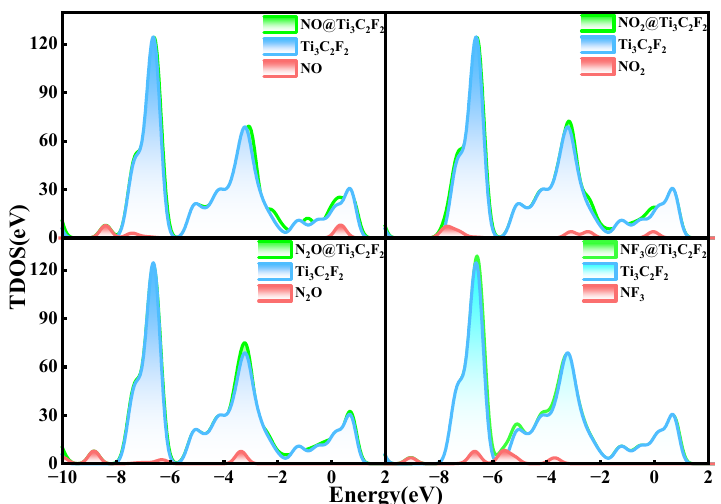
Figure 3. Total electron density of states of Ti 3 C 2 F 2 adsorbing NO, NO 2 , N 2 O, and NF 3 . In the PDOS of Figure 4, only a small part of the orbital overlaps between the atoms of NO, NO 2 , and N 2 O and the atoms of the material surface, indicating that the interactions between the atoms are not strong. The F 2p orbital of NF 3 has a partial overlap with the F 2p orbital of the surface around − 7 eV, indicating that there are some interactions between them but not the formation of a strong chemical bond. Taking all the analyses together, the adsorption of the gases on the Ti 3 C 2 F 2 surface is a physical adsorption, and there is no new chemical bond formed between the atoms composing the gas molecules and the atoms on the material surface.